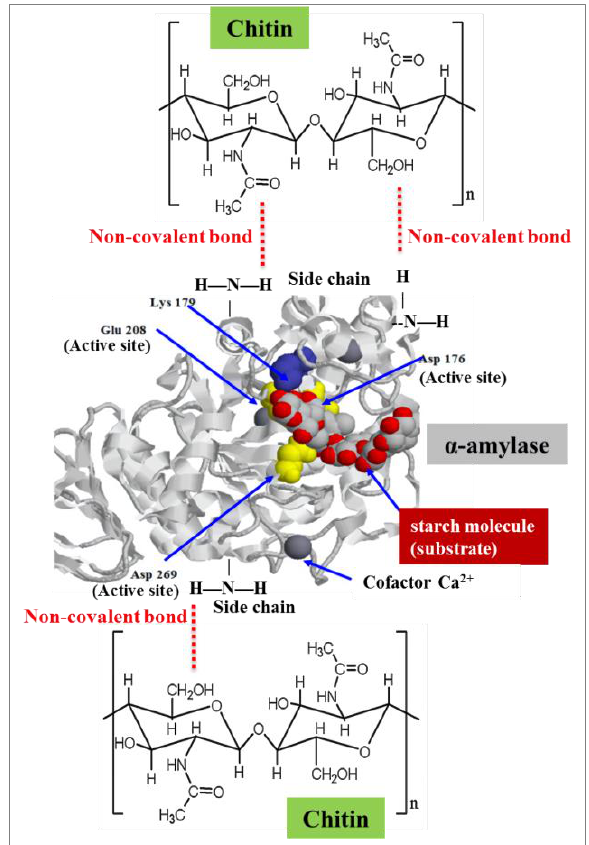
Figure 3. The illustration of α-amylase immobilization on a chitin via physical adsorption